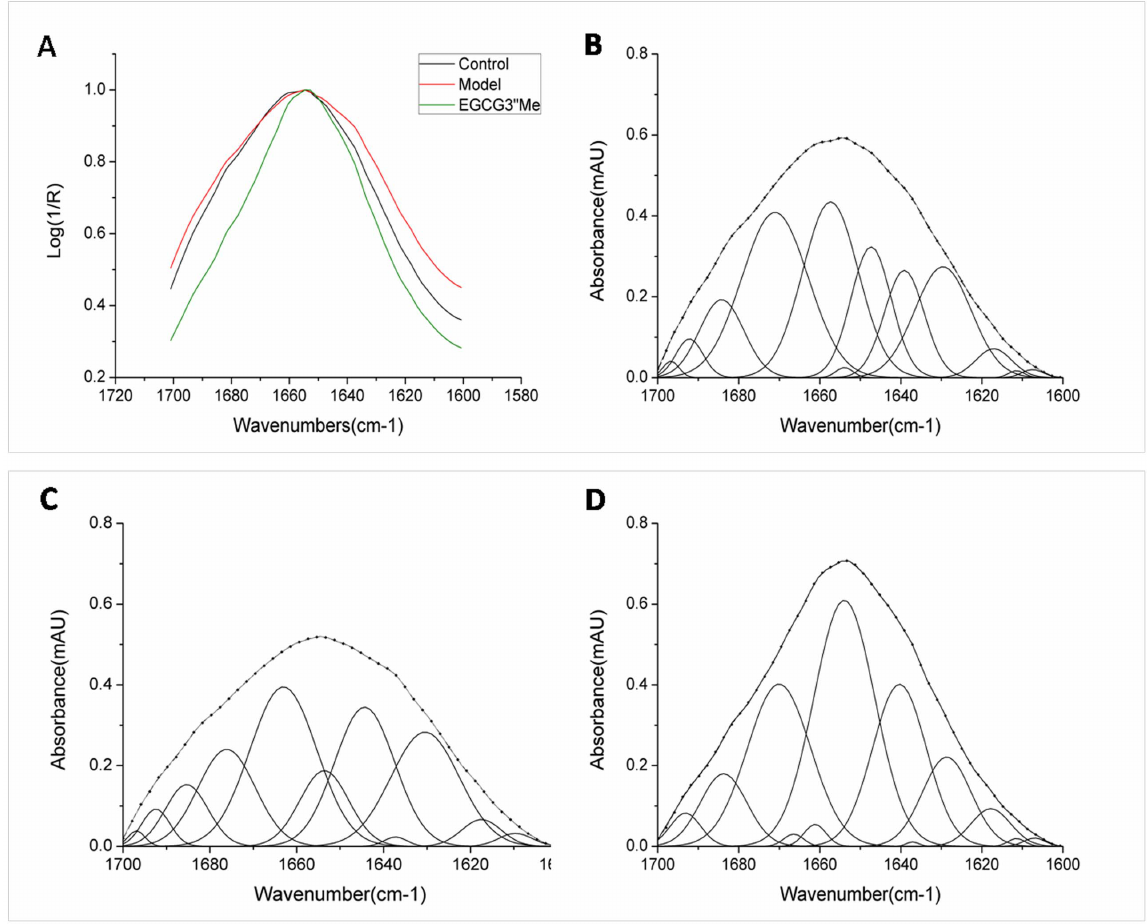
Figure 7. EGCG3’’Me treatment could sharply decrease the formation of antiparallel b -sheets in diabtetic kidneys. FTIR spectra of amide I (normalization and appropriate baselines from 1700 cm –1 to 1600 cm –1 ) show that alloxan-induced diabetic model correspond to a high b